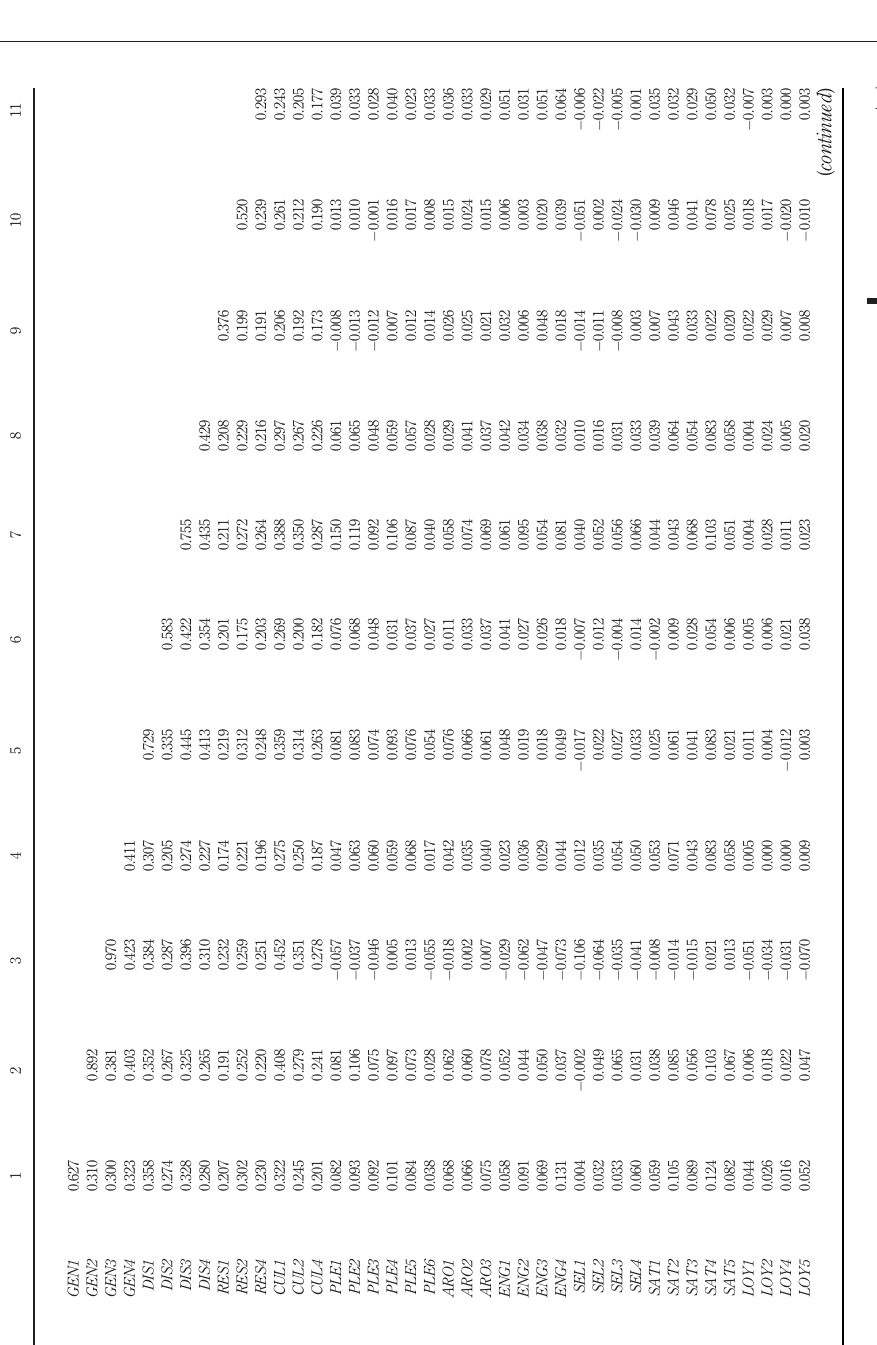
Table III. Covariance